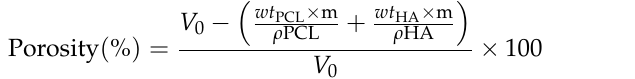
Figure 1. Schematics of the 3D-printed scaffolds with dual-pore kagome-structures: ( a ) 3D image of designed dual-pore scaffold; ( b ) 3D-printing system (material-extrusion system).